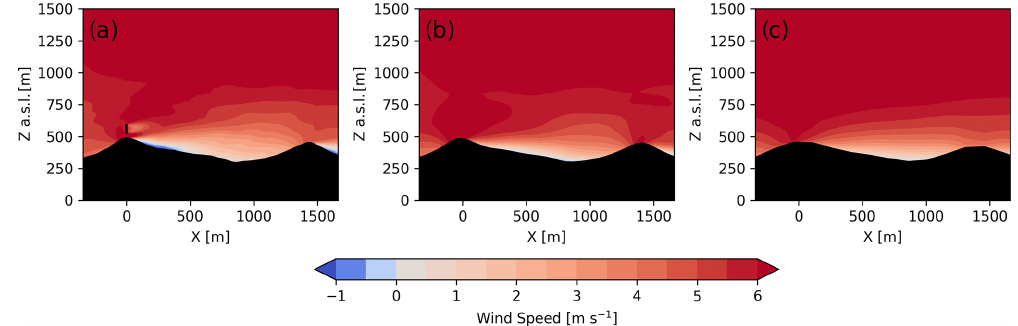
Figure A2. Transect of 1h time-averaged wind speed for (a) d05 ( (cid:49)x = 10m), (b) d04 ( (cid:49)x = 50m), and (c) d03 ( (cid:49)x = 150m) during the convective case study.